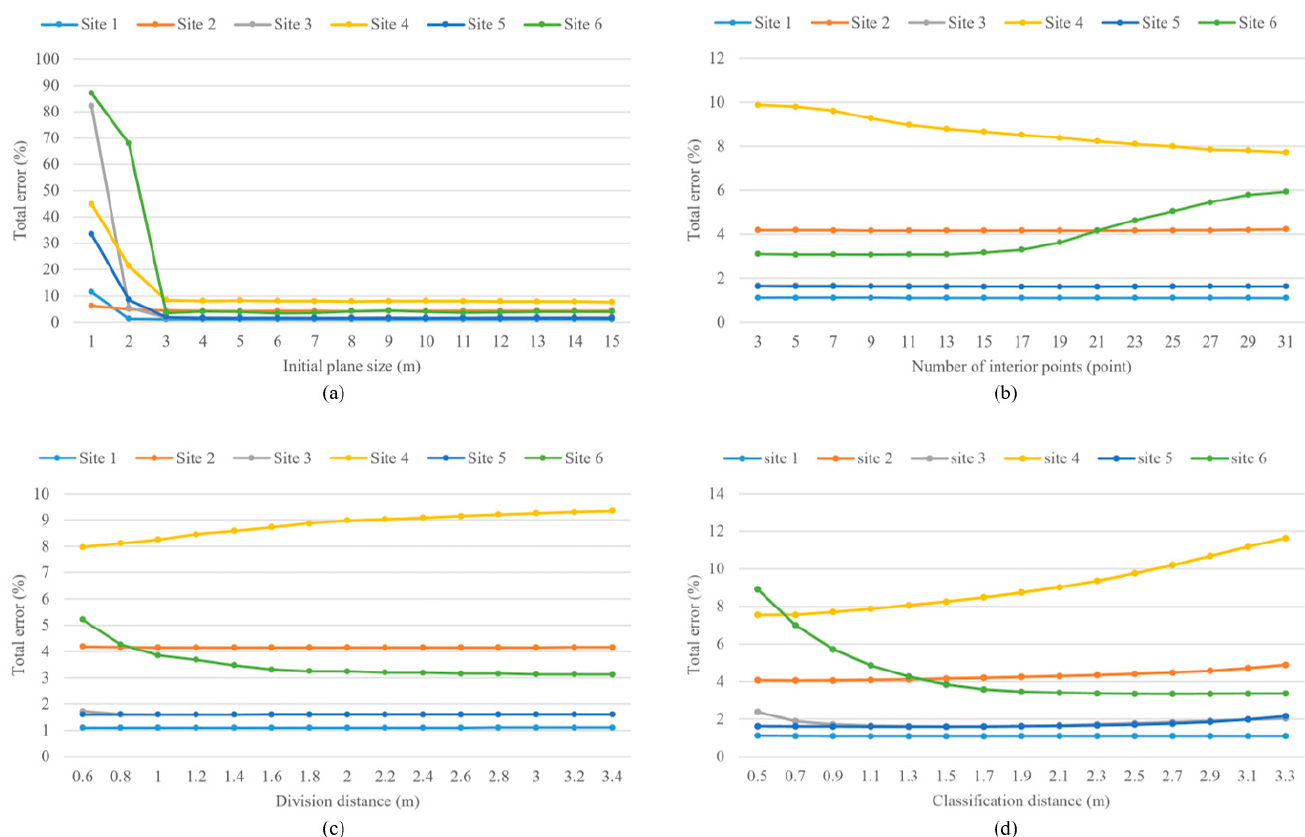
Figure 17. The sensitivity of the proposed method to the settings of ( a ) initial plane size, ( b ) number of interior points, ( c ) division distance, and ( d ) classification distance. Experiments were performed in each site. Only one parameter was adjusted in each execution, while other parameters were kept at default settings.